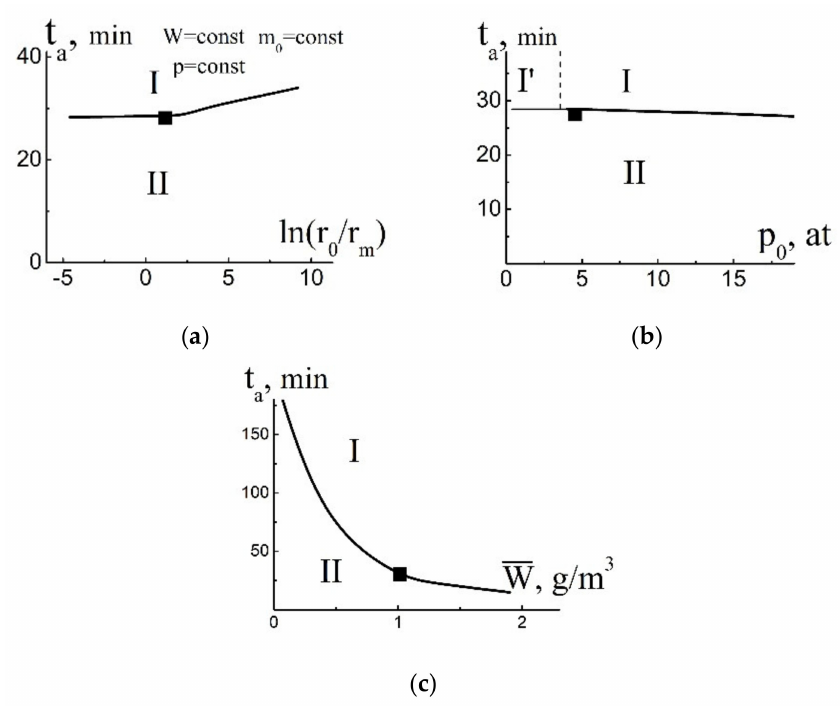
Figure 7. ( a ) Diagrams defining the different modes of mechanical activation of titanium powder in nitrogen depending on the initial size of titanium particles r 0 , ( b ) initial nitrogen pressure, ( c ) specific power of the mill W = W/V Σ ,0